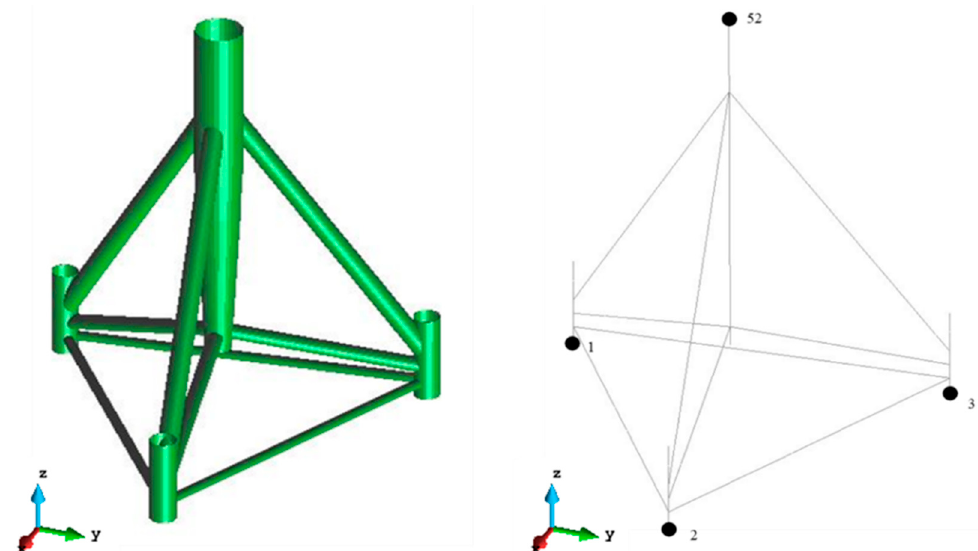
Figure 7. Model of the NREL 5MW tripod support structure. Table 1. Geometry and material properties of the tripod support structure.